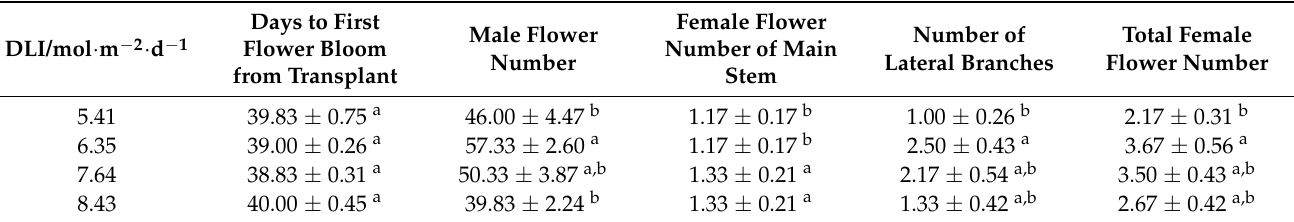
Table 3. The effect of DLI on cucumber plant flowering after transplant of cucumber plug seedlings in run 2 *.